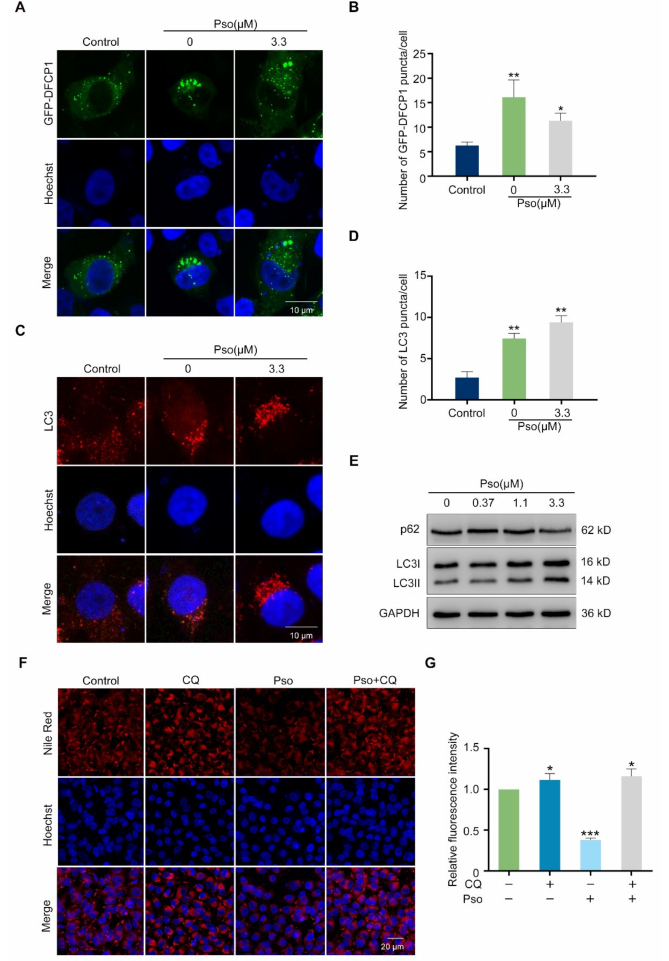
Figure 3. Psoralen inhibits lipid accumulation by promoting autophagy. ( A ) L02 cells were transfected with GFP-DFCP1 plasmid, induced by sodium oleate (100 µ M) for 24 h, and incubated with